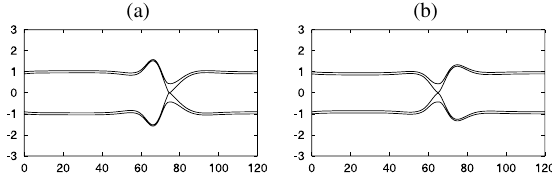
Fig. 7 Breakup profiles of the jet for di ff erent η when ρ = 0 . 001, σ = 1, ¯ b = 0 . 1 and ¯ u 1 = ¯ u 2 = 1, where Wb = 1280 and ω = 0 . 0125; (a) η = 0 . 1 and (b) η = − 0 .